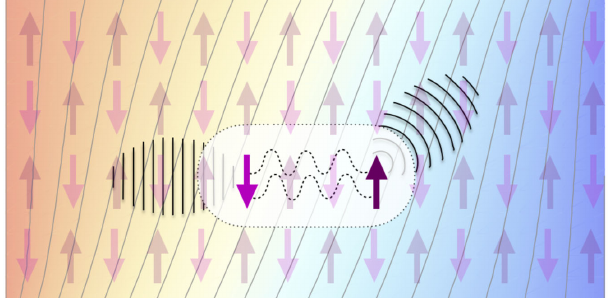
FIG. 1. Illustration of a scattering mechanism responsible for a Hall effect. Only scattering processes that involve at least two (virtual) collisions with collective fluctuations can contribute to a Hall